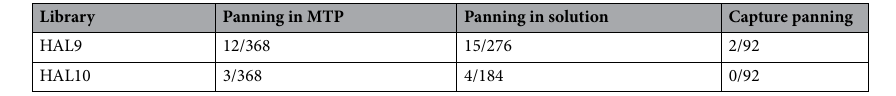
Table 1. Selection of unique binders against eqIL-5 via different antibody phage display